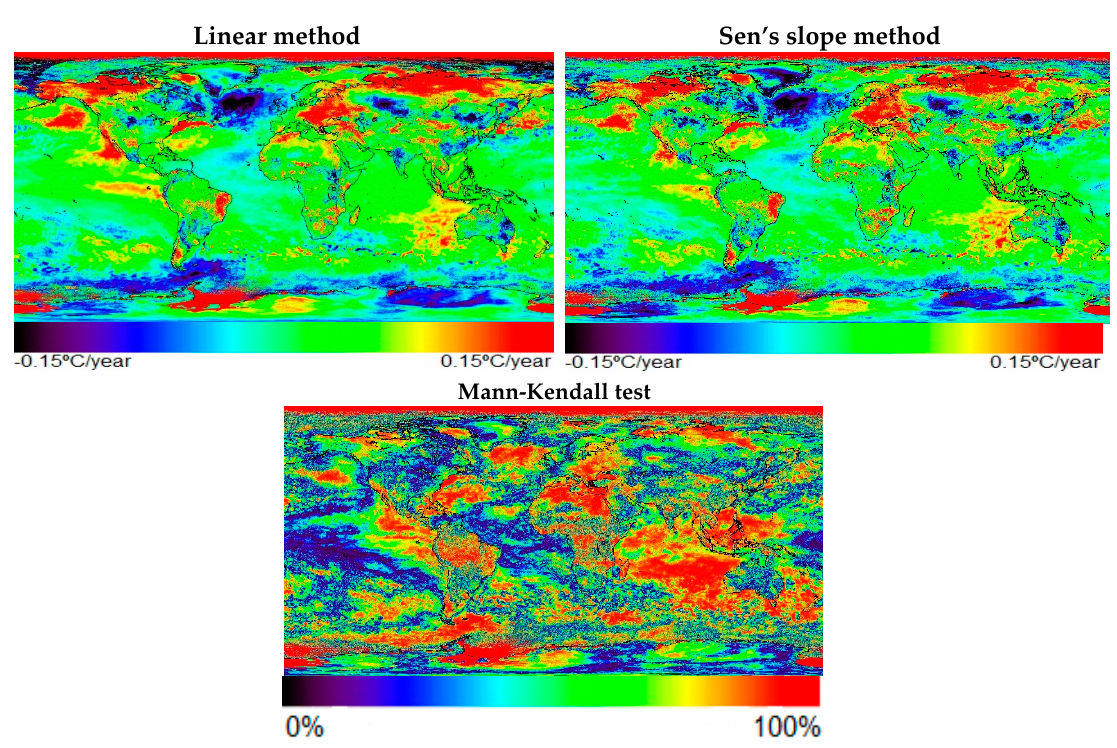
Figure 4. Global linear trend map for the period 2003–2016 estimated by the linear ( left ) and Sen’s slope ( right ) methods, with results of 0.018 °C/yr and 0.017 °C/yr, respectively. The Mann-Kendall test significance map is also provided.